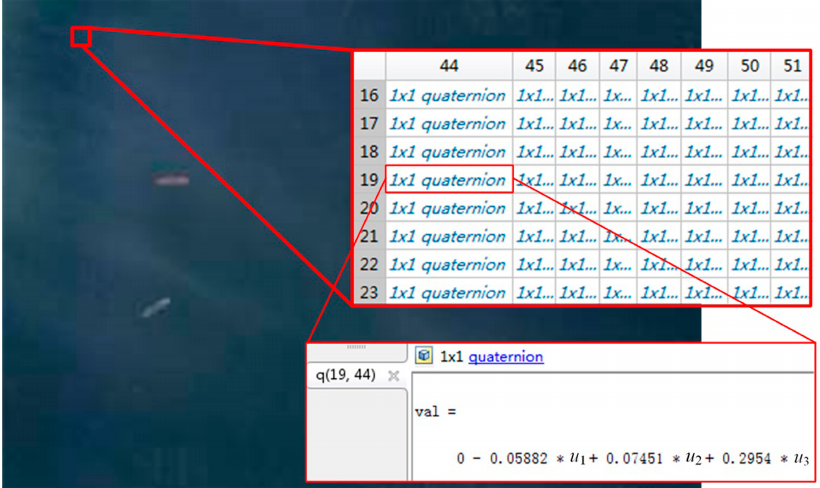
Figure 3. Image represented by quaternions.